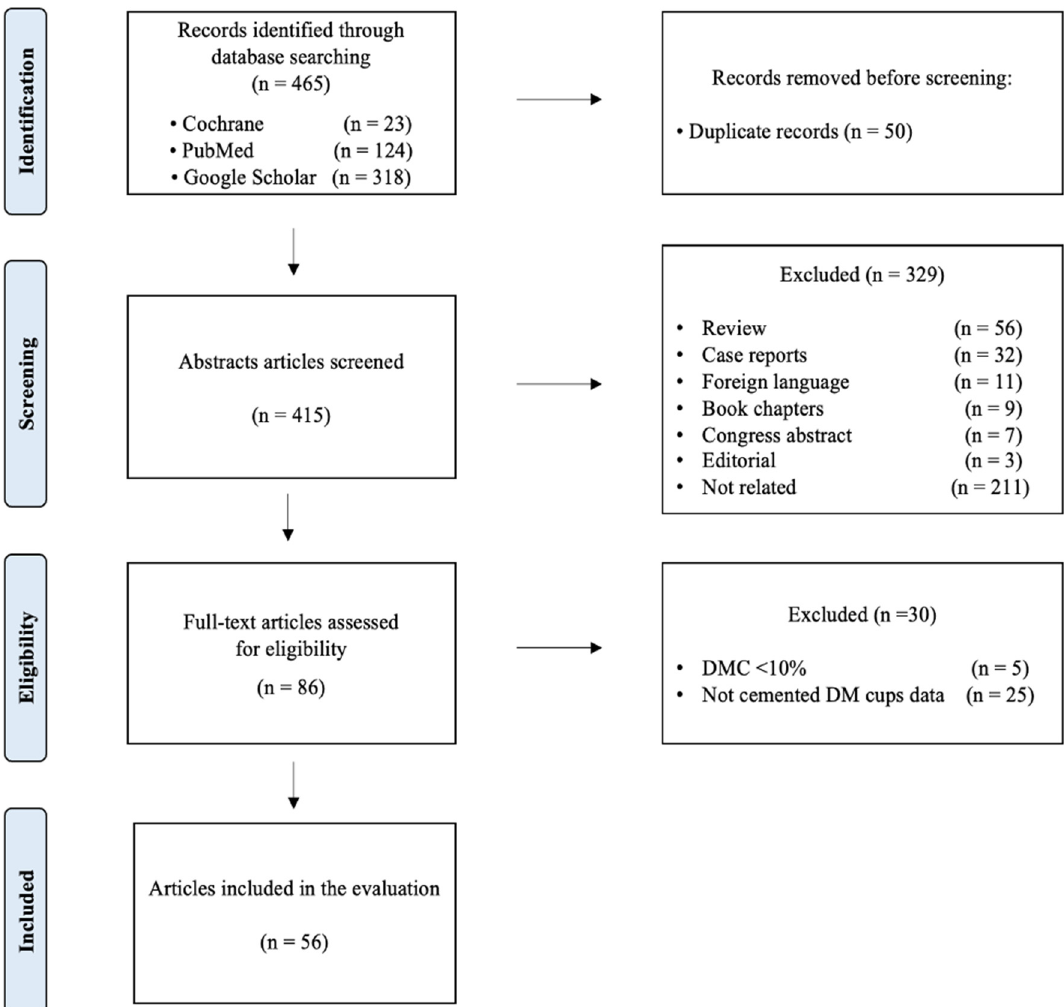
Figure 1. Prisma Flowchart from the identification to the inclusion.